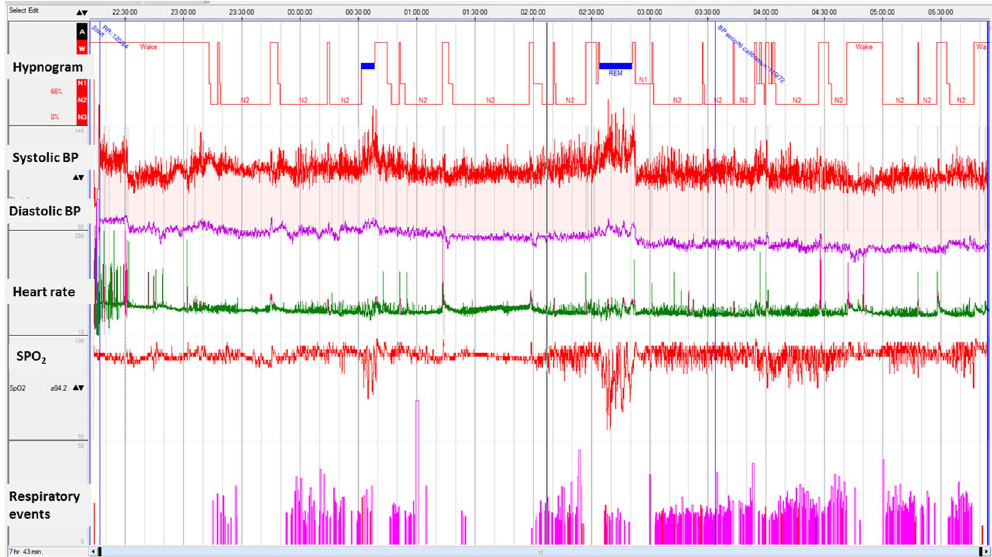
Figure 1. A histogram of a patient showing an increase in blood pressure during REM sleep with significant desaturation.